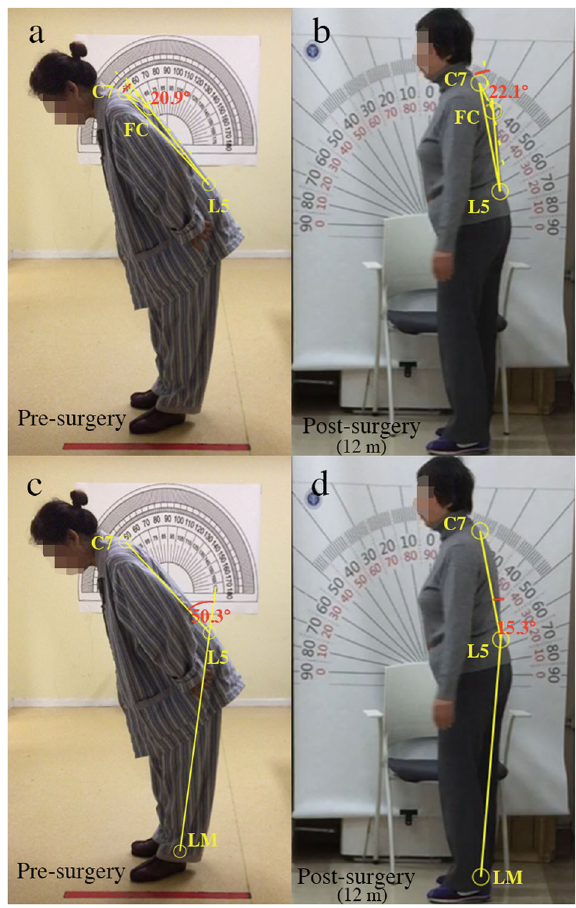
Fig. 7 Measurement of the camptocormia angles angle in a patient with TCC-camptocormia pre- and post surgery. a Pre- surgical UCC angle; b UCC angle at 12 month post-surgery; c post- surgical TCC angle; d TCC angle at 12 months post-surgery. Written consent was obtained for publication of the photographs. C7: spinous process of vertebra C7; L5: suspected location of the spinous process of vertebra L5; LM: lateral malleolus; FC: vertebral fulcrum, the point with the greatest distance from the